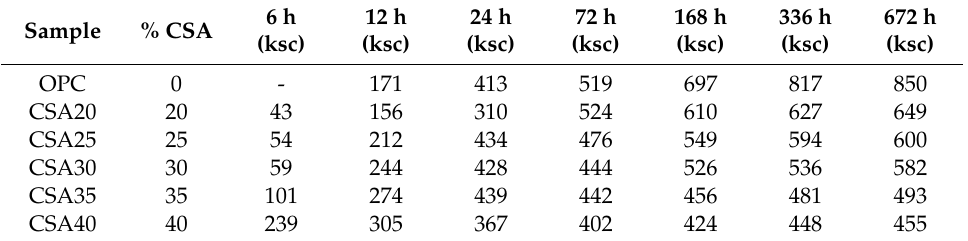
Table 5. Compressive strength of cement pastes at different curing periods.